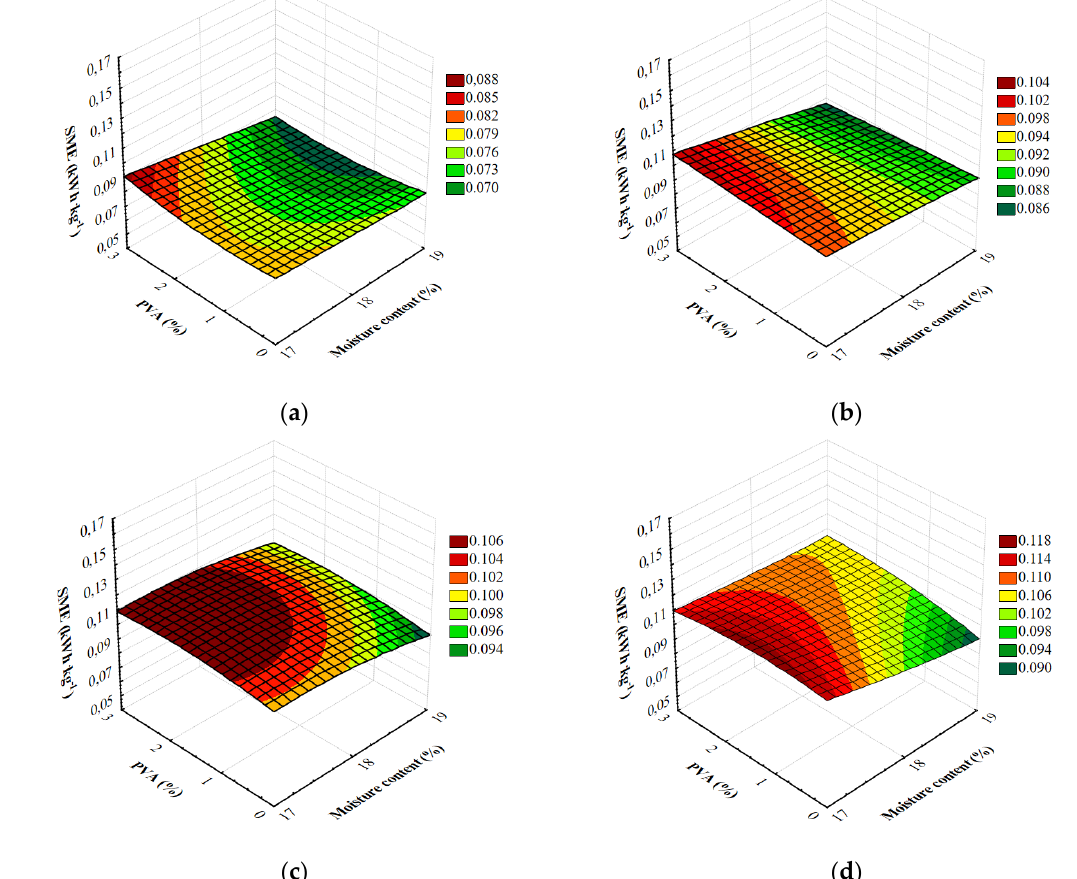
Figure 4. Specific mechanical energy of starch foams extrusion with various amounts of PVA and the initial moisture content of raw materials processed with different forming dies at various screw speeds: ( a ) M1-S1, ( b ) M1-S2, ( c ) M2-S1 and ( d ) M2-S2.